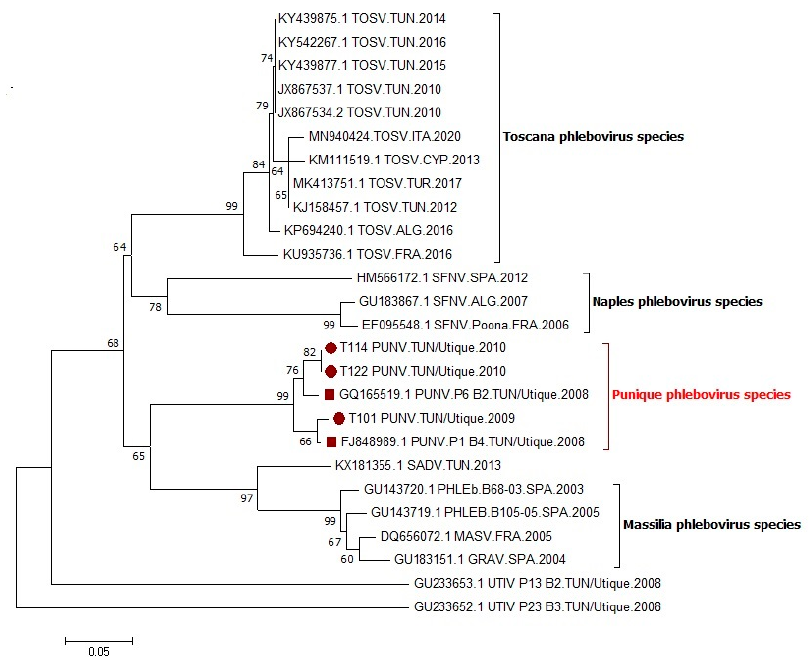
Figure 2. Phylogenetic analysis of PUNV with selected phleboviruses using partial sequences of the polymerase gene available in GenBank. Tree topology was determined by neighbor-joining method within MEGA5, and supported by 1000 bootstrap